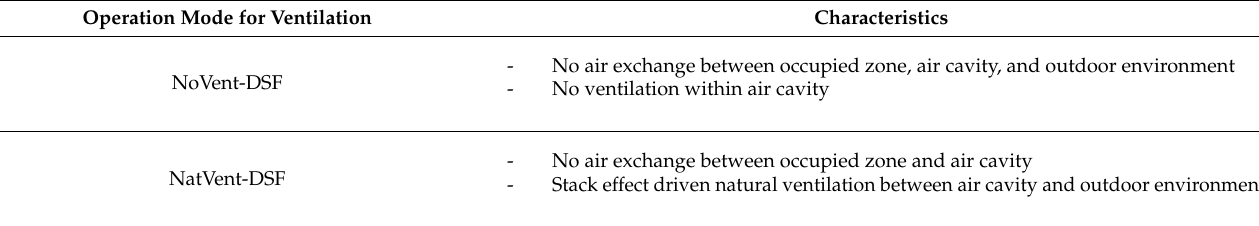
Figure 3. BIPV-DSF typologies in terms of operation modes for ventilation. Table 4. Characteristics of the two BIPV-DSF typologies.